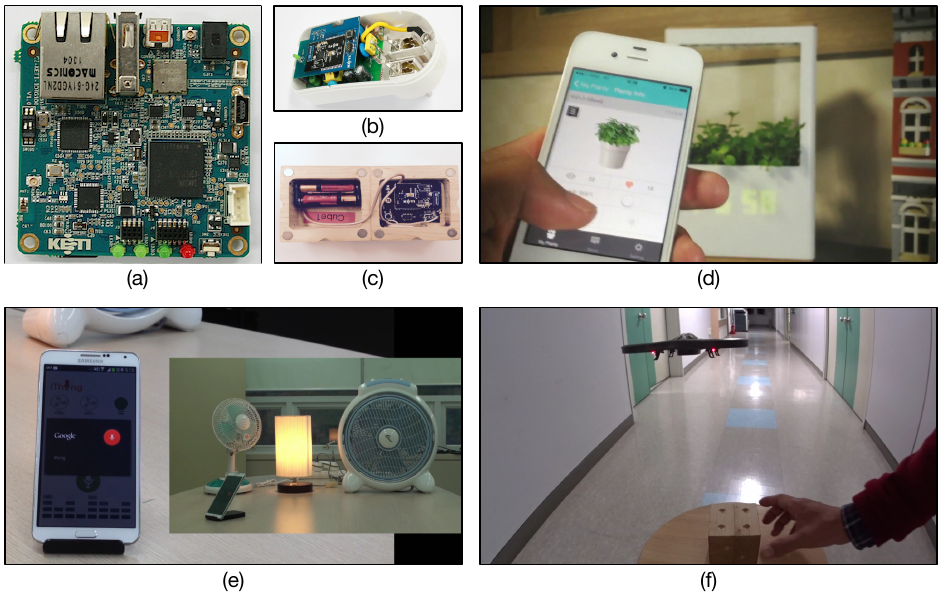
Figure 13. The prototype IoT devices and services: ( a ) IoT gateway IoTG100; ( b ) smart plug; ( c ) smart dice; ( d ) Planty; ( e ) iThing and ( f )